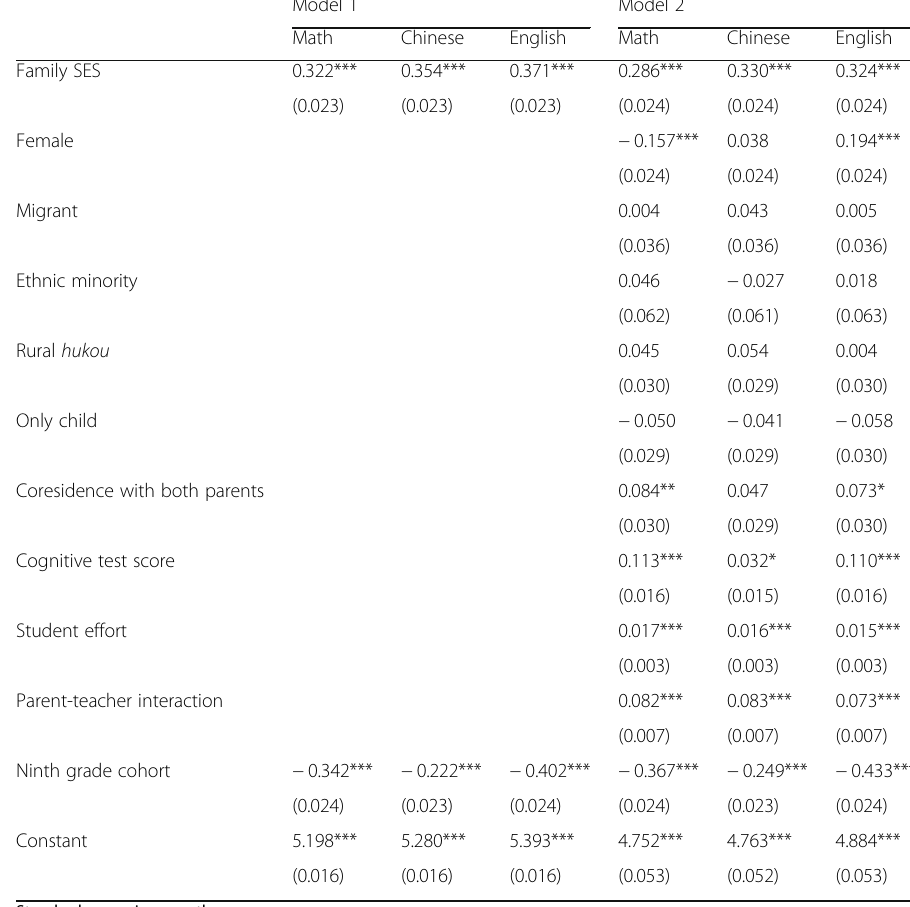
Table 4 School fixed effect models predicting student-teacher interaction ( N =